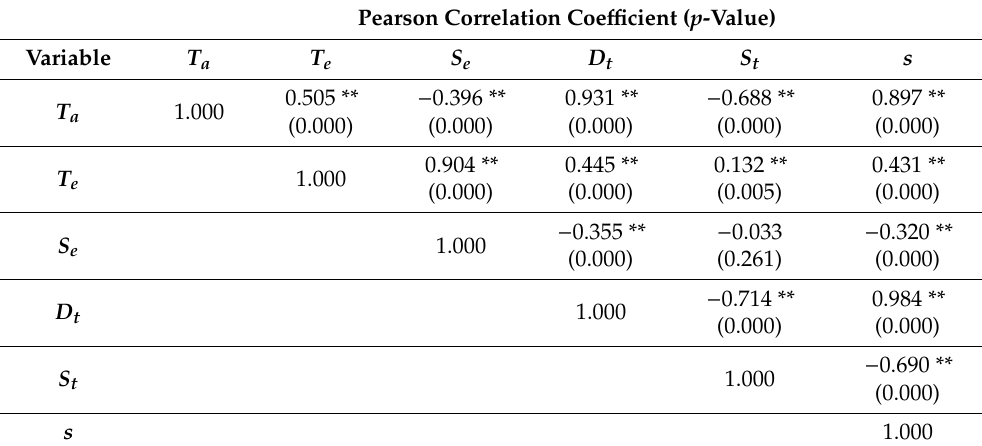
Table 5. Correlation matrix for variables for predicting axle